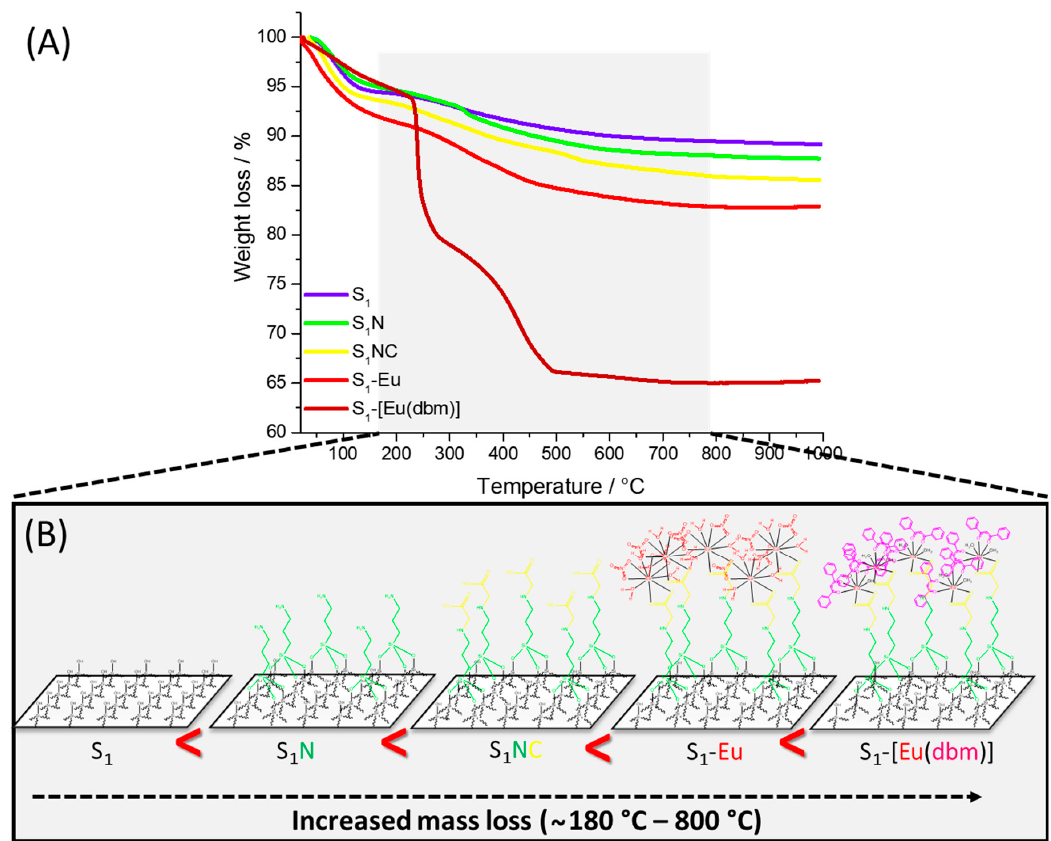
Figure 3. ( A ) Thermogravimetric curves of all samples obtained after each functionalization step. ( B ) Surface illustrative representation of all samples, elucidating the increase of organic matter losses during the second thermal event.